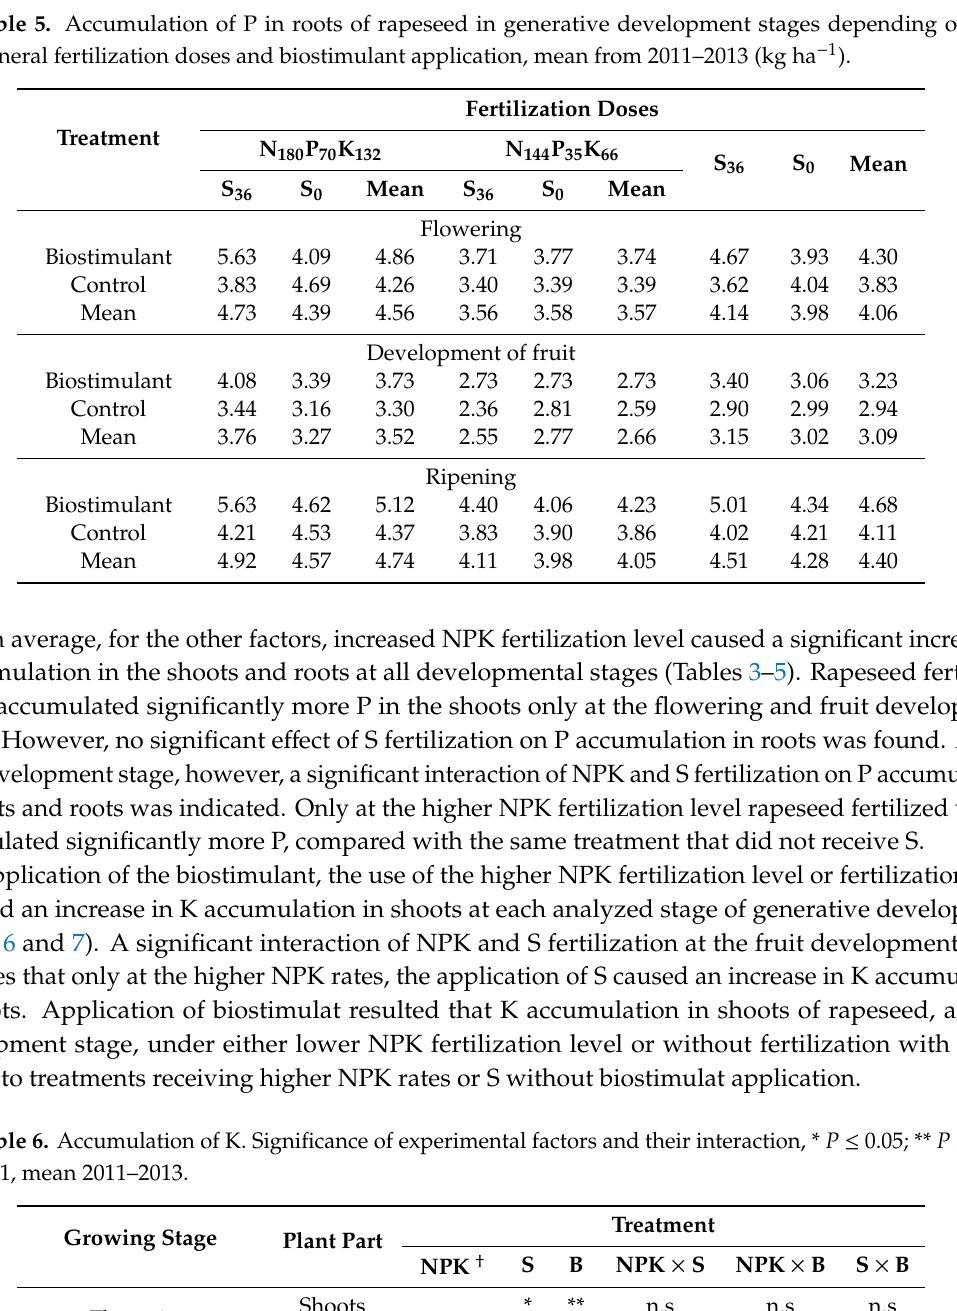
Table 5. Accumulation of P in roots of rapeseed in generative development stages depending on